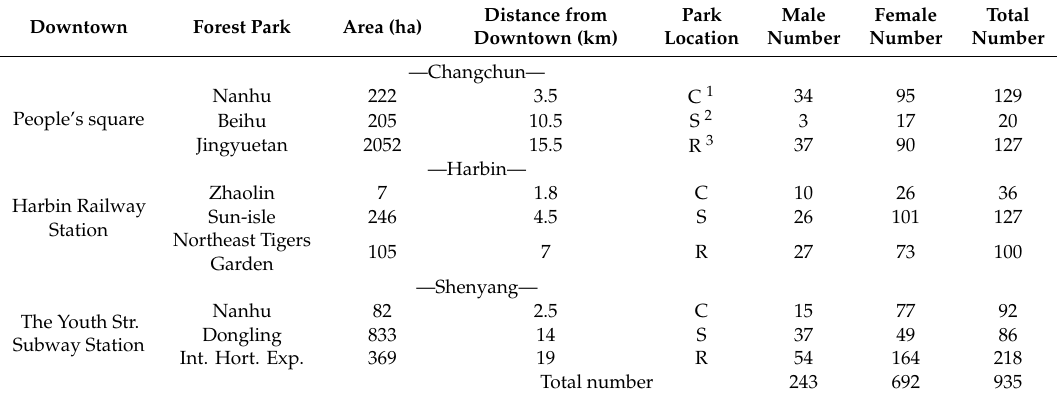
Table 1. Details about name, area, and location of urban forest parks and number of two genders of visitors therein in cities of Changchun, Harbin, and Shenyang in Northeast